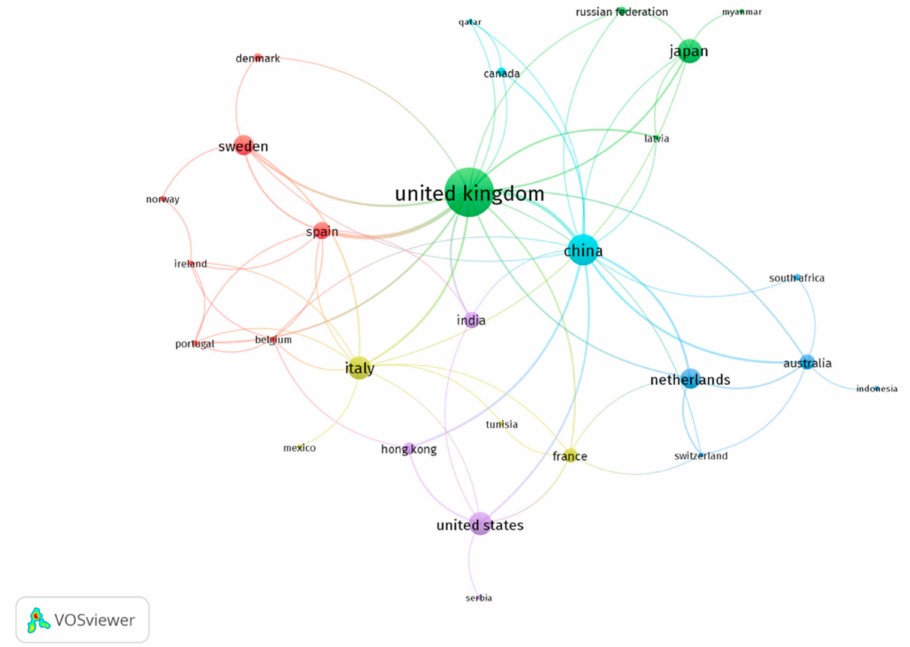
Figure 12. Countries’ specific cooperation in the research on “condition monitoring”. Source: Own study applied using VOSviewer software (version